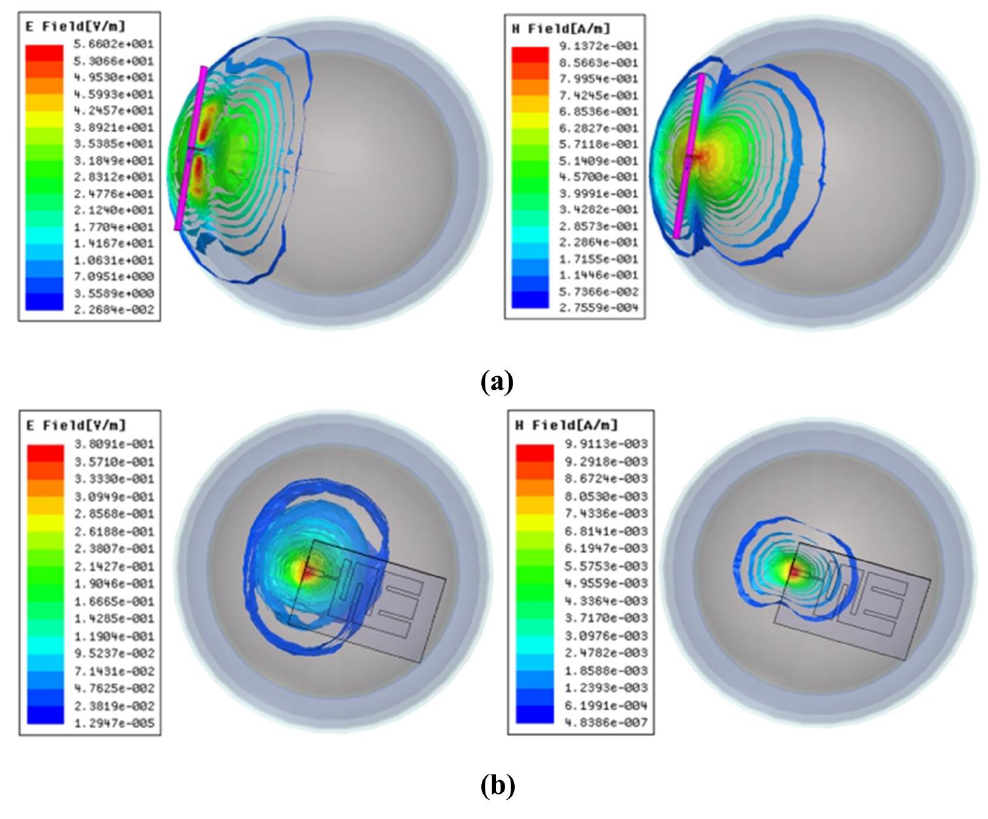
Figure 8. The fields distribution in the head caused by: (a) Dipole antenna. (b) Patch antenna.